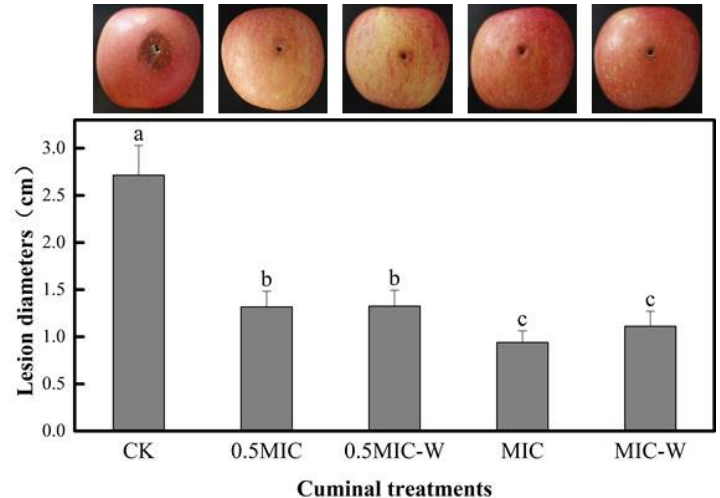
Figure 2. In vivo antifungal effect of cuminal against T. roseum on apple fruits. Bars with different letters indicate mean values significantly different at P < 0.05 according to Tukey test. Data are expressed as mean of three replicates±SD.